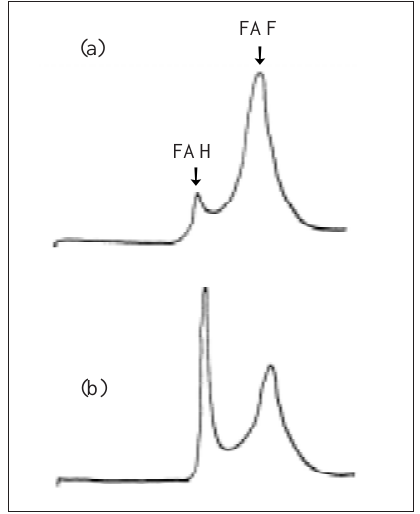
Figura 2. Cromatogramas de substâncias húmicas originárias de Latossolo sob floresta e extraídas: (a) Com NaOH 0,1 M e (b) Com resina Chelex.